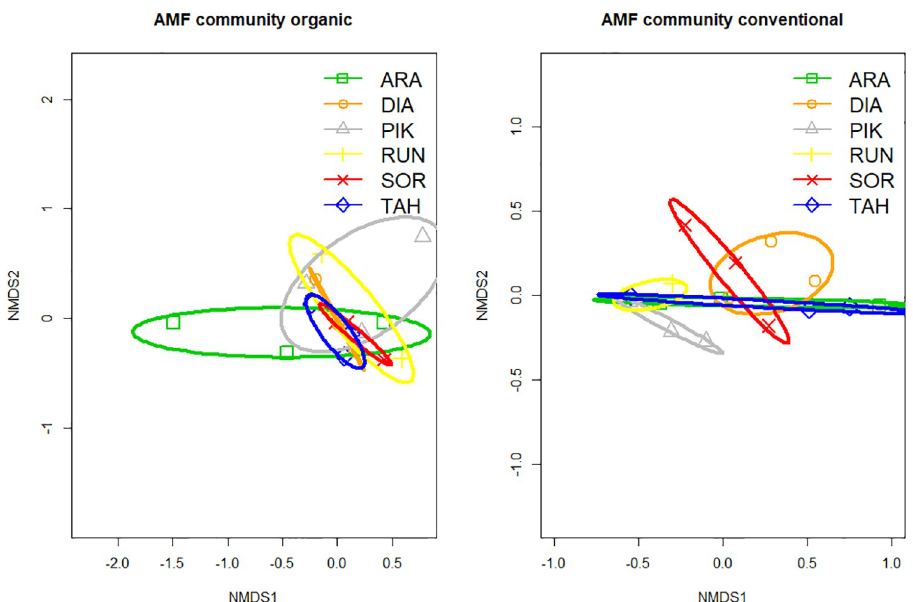
Fig 5. Nonmetric multidimensional scaling (NMDS) of AM fungal communities in roots of wheat cultivars grown with organic (left) and conventional (right) field soil inoculum. ARA: Arabella 2012, DIA: Diamant: 1929, PIK: Pikker 1959, RUN: Runar 1972, SOR: Sorbas 2016, and TAH: Ta¨hti 1972. Each point represents one sample; ellipses show one standard error around group